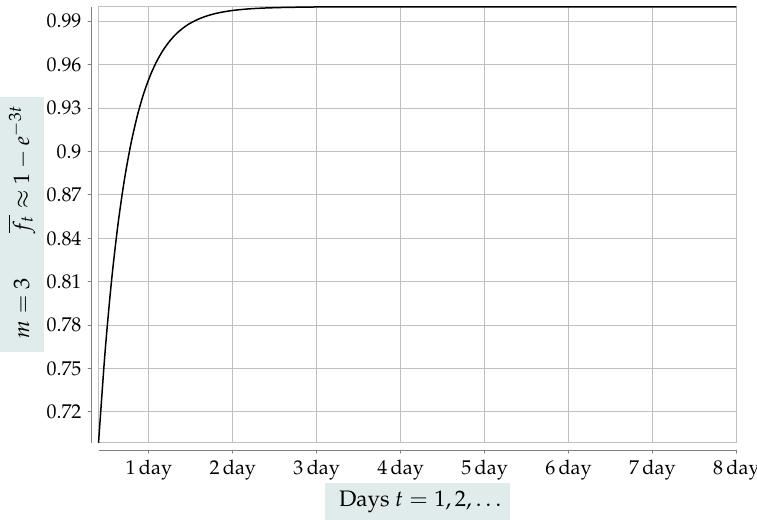
Figure 6. This figure depicts the approximate expected utilization f t ≈ 1 − e − 3 t as given by Equation (31) for m =